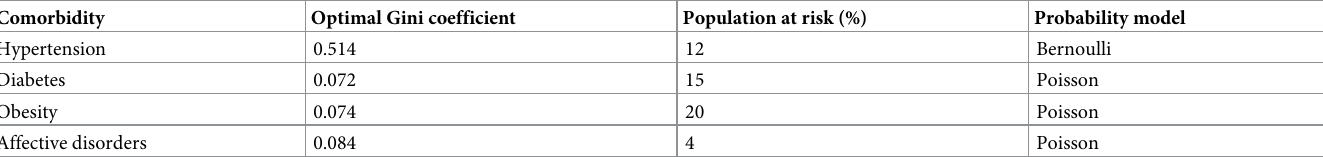
Table 1. Used Gini coefficients, percentages of the population at risk and probability